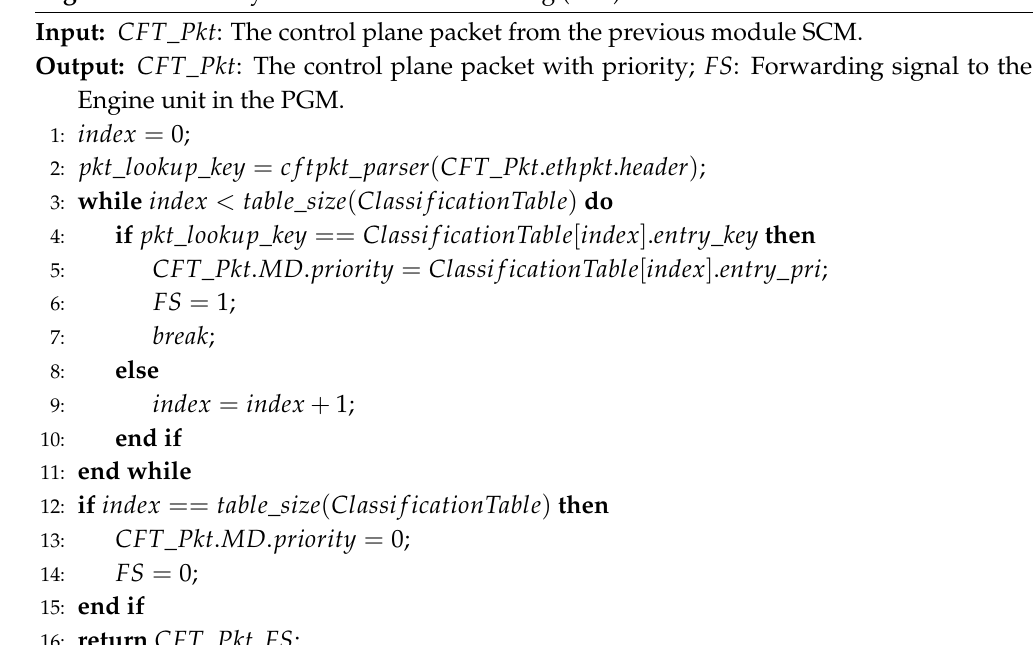
Algorithm 1 Priority-based Packets Scheduling (PPS)